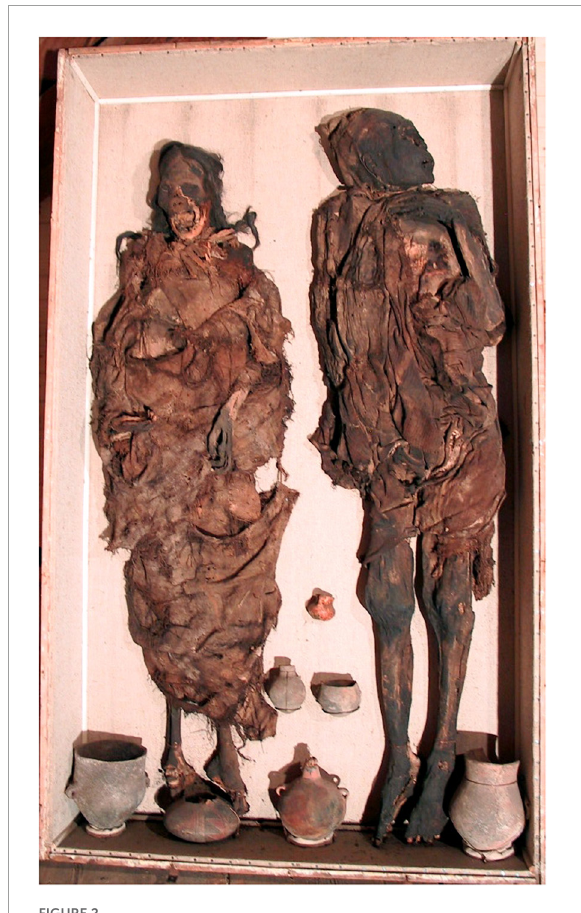
FIGURE2 The “Delémont man” (right) and the “Delémont woman” (left) —“overview of the two mummies in their repository case.”